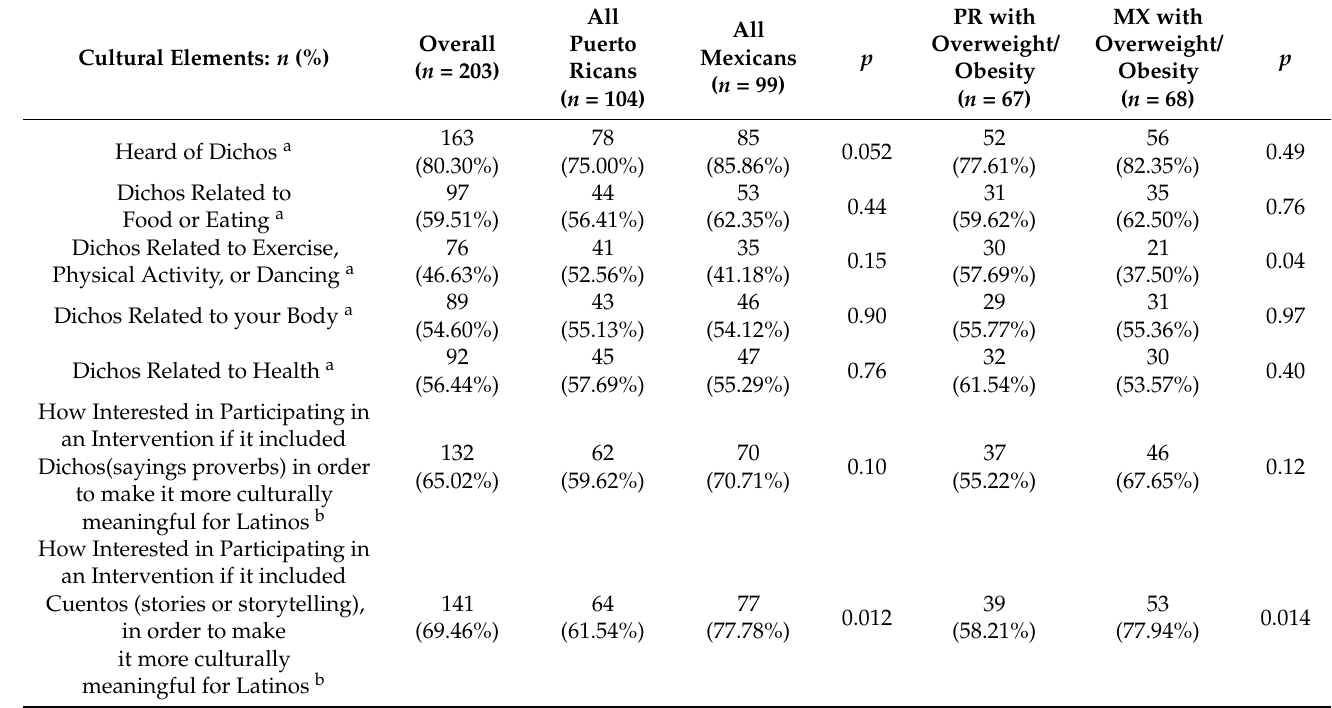
Table 3. Preferences for the Location of Intervention and Exercise among All Participants and Participants with